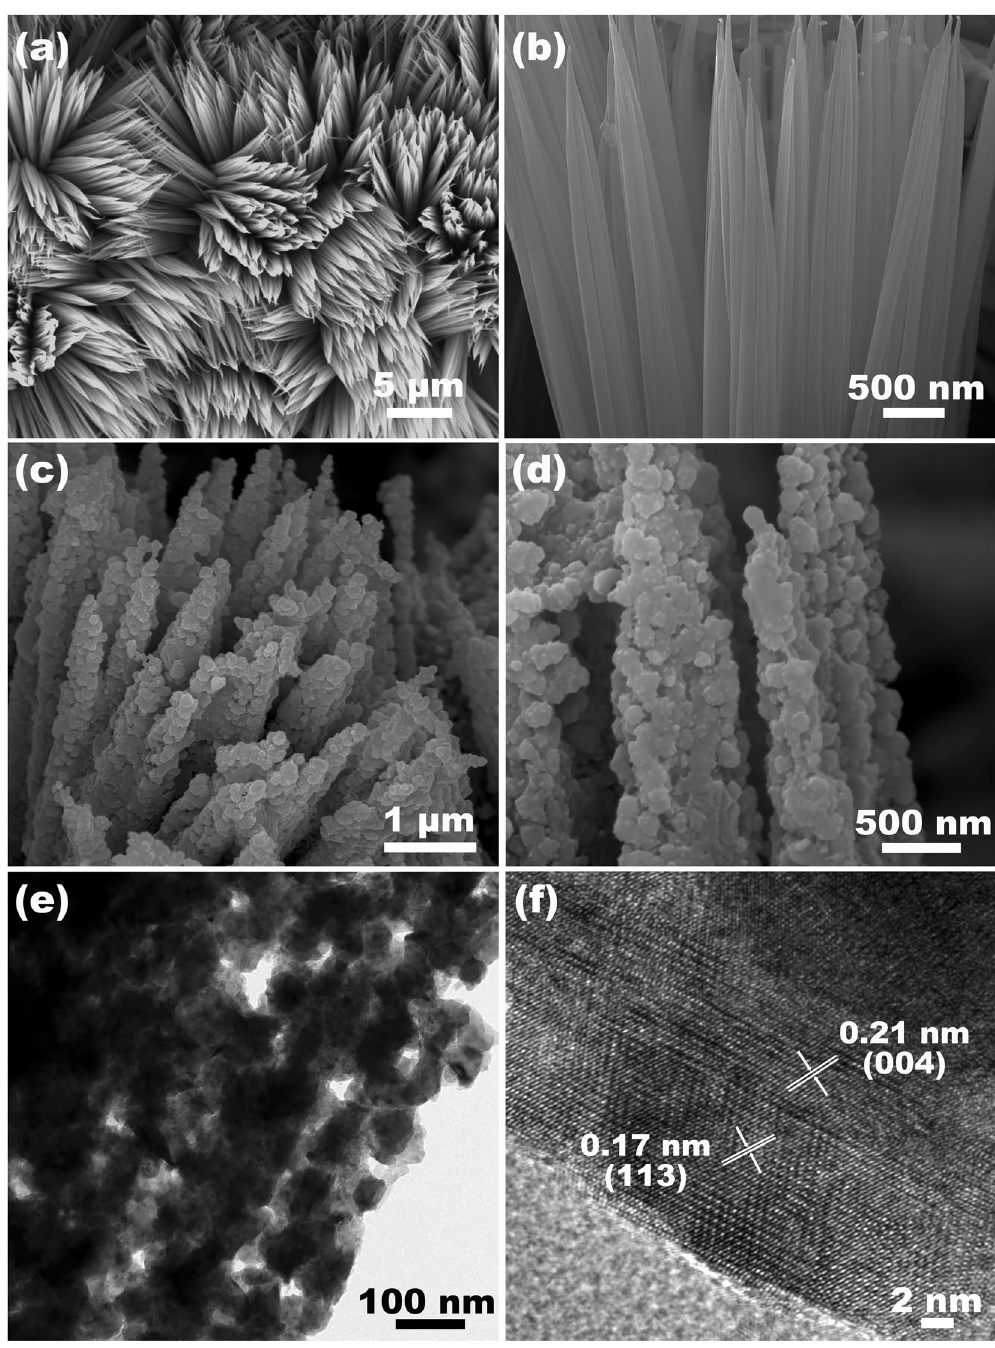
Figure 3. FESEM images of ( a , b ) the Cu-Co precursor nanowire arrays and ( c , d ) the CuCo 2 S 4 NRAs on carbon textiles at different magnifications, ( e ) TEM and ( f ) HRTEM image of the CuCo 2 S 4 NRAs scratched from carbon